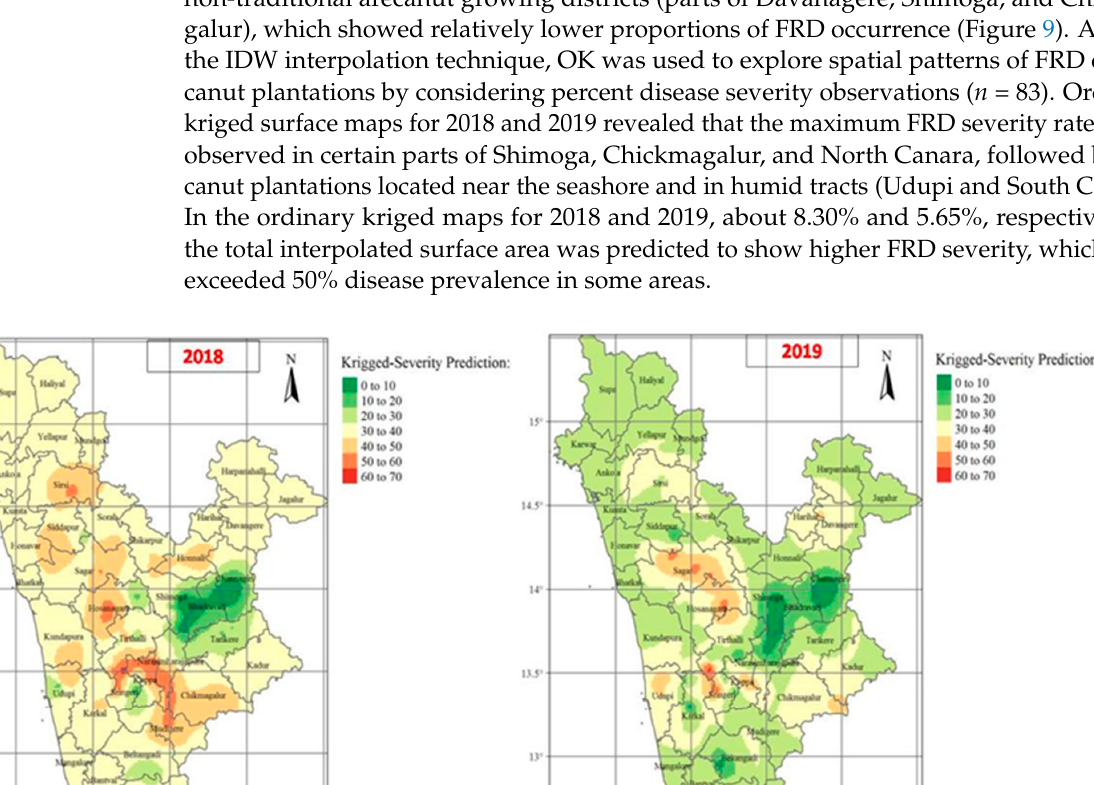
Figure 8. Histograms and normal QQ plots of FRD percent severity data used to understand the distribution of the dataset.